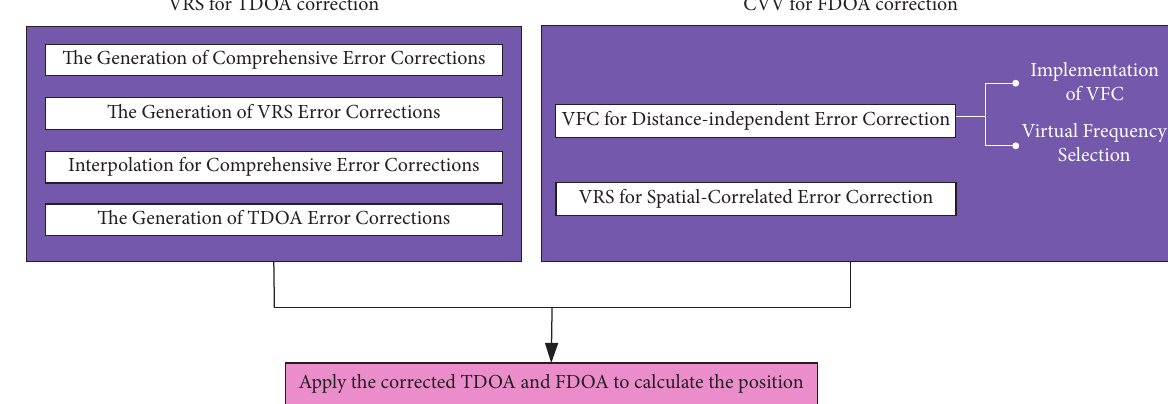
Figure 2: The flowchart of the proposed systematic error correction method.